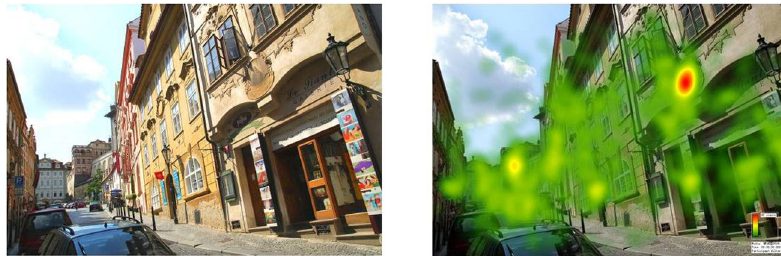
Fig. 9 The eye motion and heatmap comparison for a typical residential street scene.